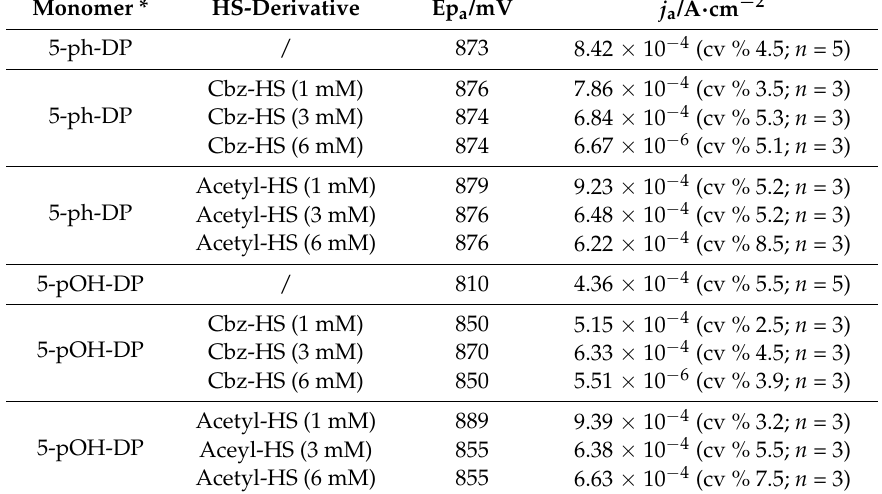
Table 3. Epa and j a variation of the first oxidation process of dipyrromethanes in solutions with